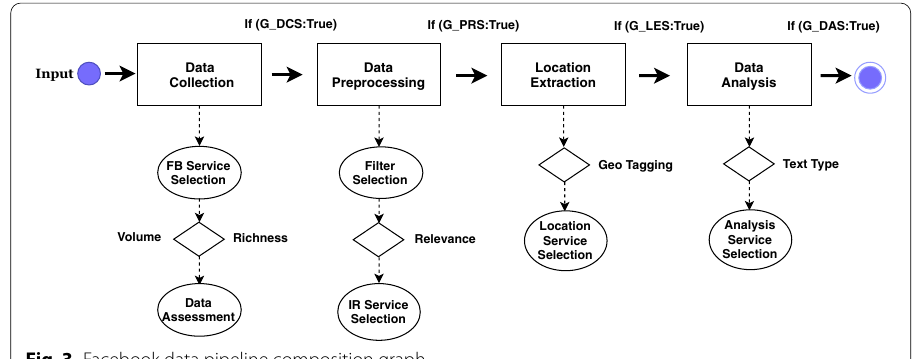
Fig. 3 Facebook data pipeline composition